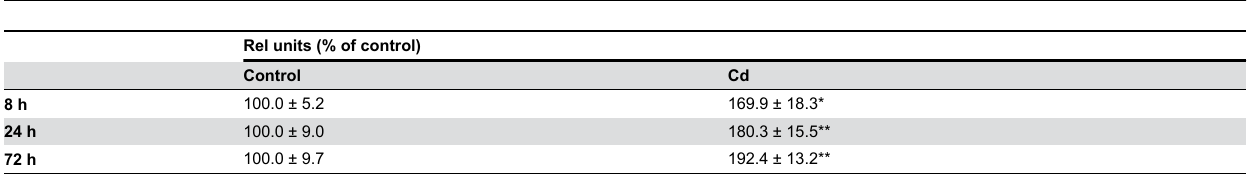
Anterior pituitary cells were treated with vehicle (control) or 10 nM Cd for 8, 24 or 72 h. Prolactin mRNA was determined by PCR. Densitometric values were normalized to GAPDH expression and are expressed as mean ± SE. ANOVA followed by Tukey-Kramer’s test, *p<0.05, **p<0.01 vs. respective control.